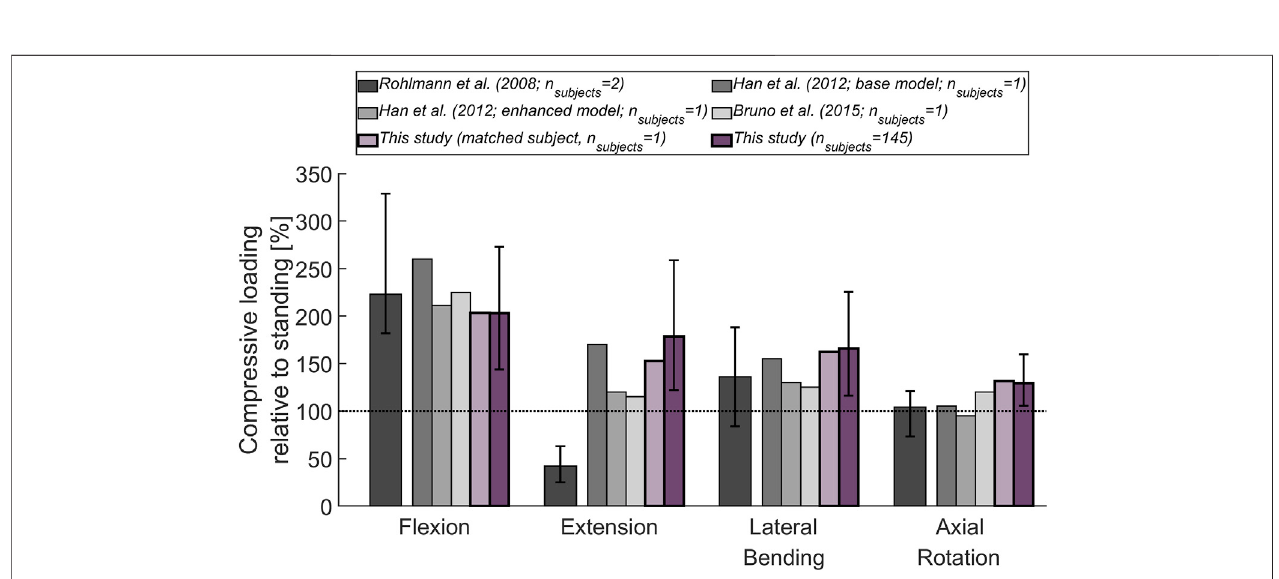
FIGURE 6 | Compressive load at L1L2 (relative to standing position) derived from in vivo measurements (Rohlmann et al., 2008) and from previously published thoracolumbarmusculoskeletalmodels(Hanetal.,2012;Brunoetal.,2015).Theseresultsarebeingcomparedtothemeancompressivejointloadobtainedforthe145 subjectsconsideredinthisstudy(darkpurple)andforasubject(male,74 years,69 kg;lightpurple)withageandweightpropertiescomparabletothoseofthesubjectsin the experiments. The base model of Han et al. (2012) did not incorporate properties derived from passive elements or aspects of muscle dynamics, while these features were added in the enhanced model presented in the same publication. The error bars indicate the range between minimum and maximum values.